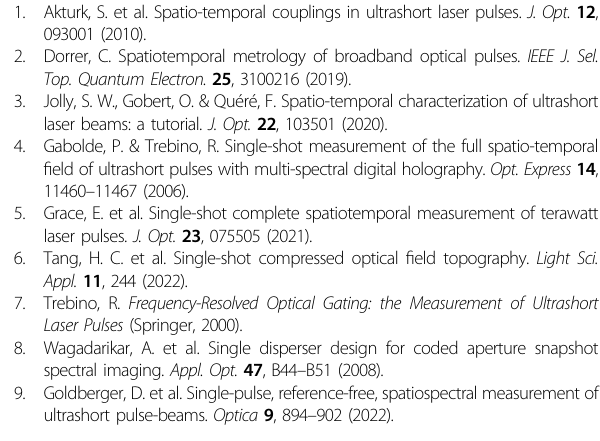
in one shot using two devices, a CCD camera and a Frequency-resolved Optical Gating device (FROG) 7 . On